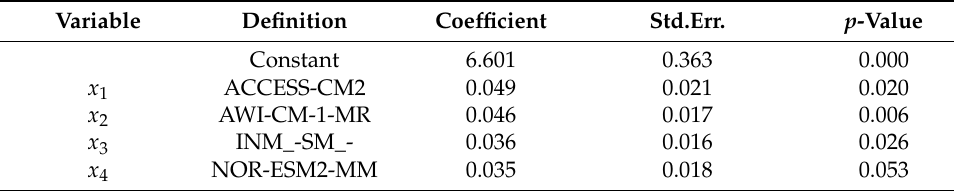
Table 4. Final regression model with satistical